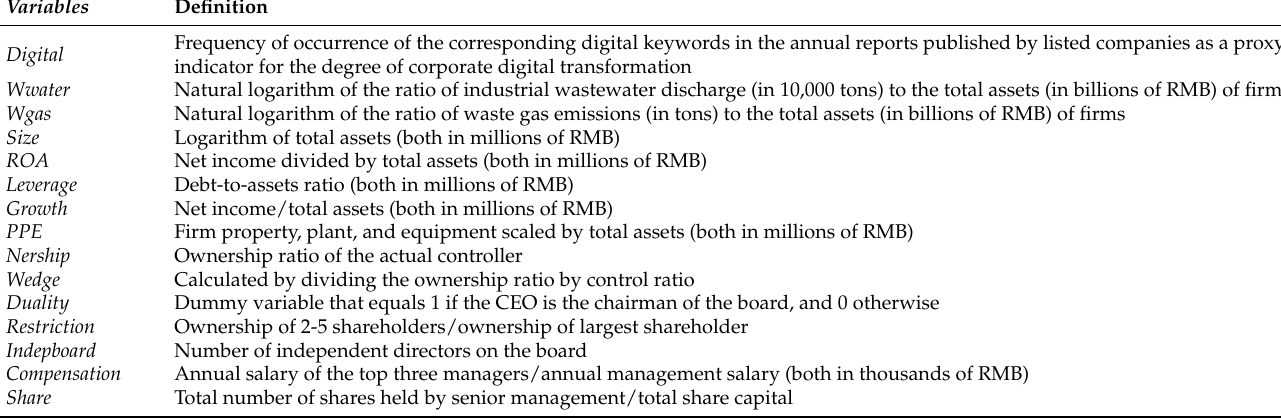
Table A1. Variable